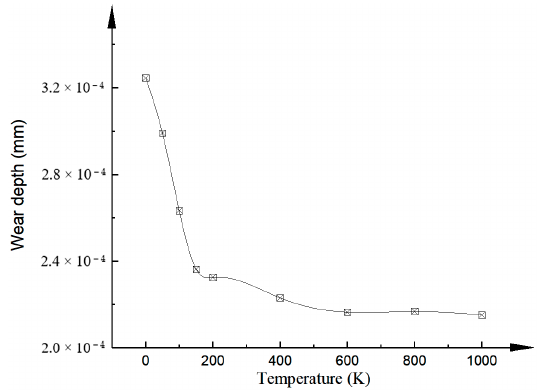
Figure 20. Depth of wear rate as a function of temperature.